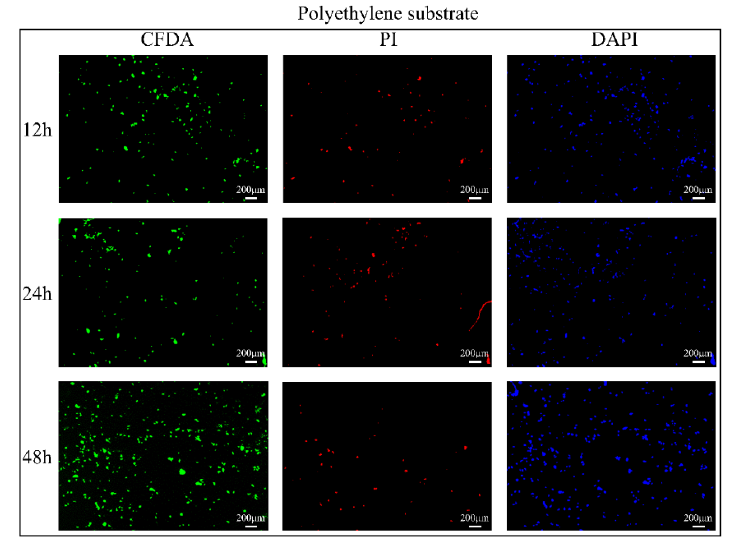
Figure 6. Fluorescence micrographs of the PE substrate after bacteria testing. Green stain (CFDA) marked the live bacteria, the red stain (PI) the dead bacteria, and the blue stain (DAPI) the bacterial cells’ nuclei.